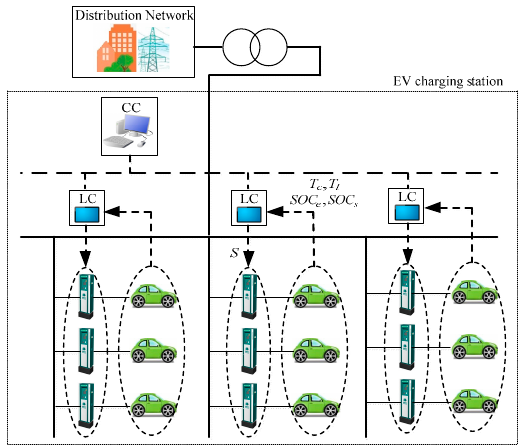
Figure 5. Decentralized control architecture.